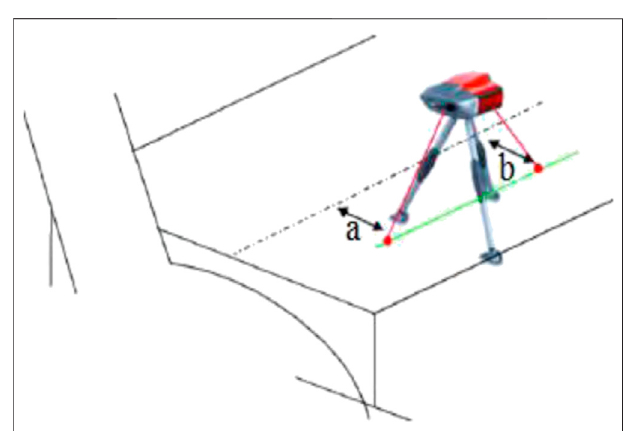
FIGURE 2 | Calibration of laser radar measuring instrument installation